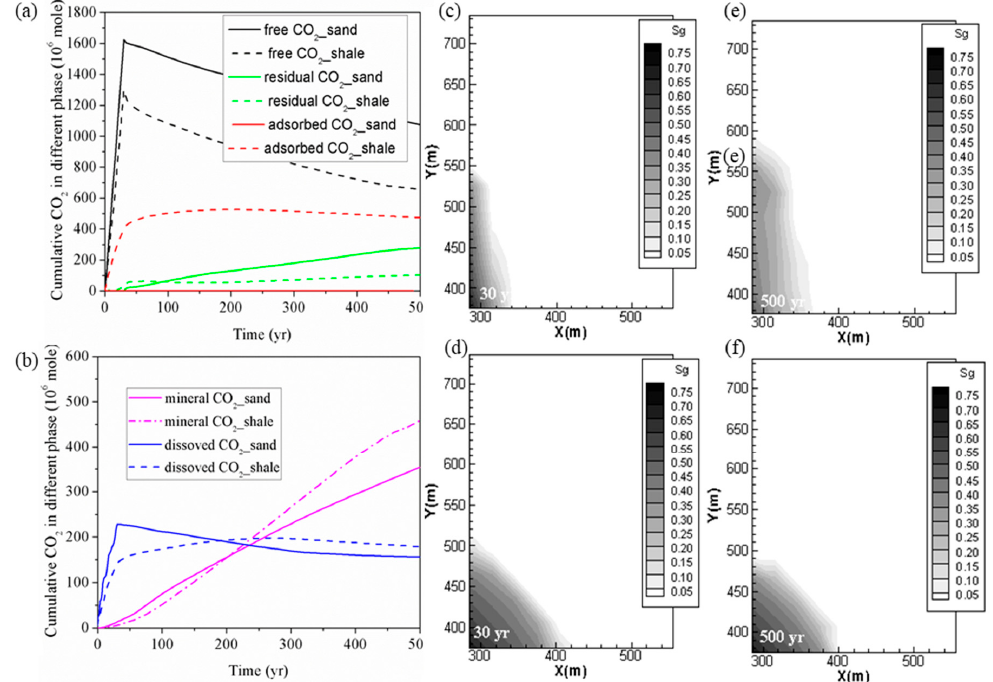
Figure 5. ( a , b ) Cumulative CO 2 storage under different mechanisms in shale and sand; ( c , e ) free CO 2 distribution for case 1 (YC shale) at 30 years and 500 years; ( d , f ) free CO 2 distribution for case 2 (LJG sand) at 30 years and 500 years.